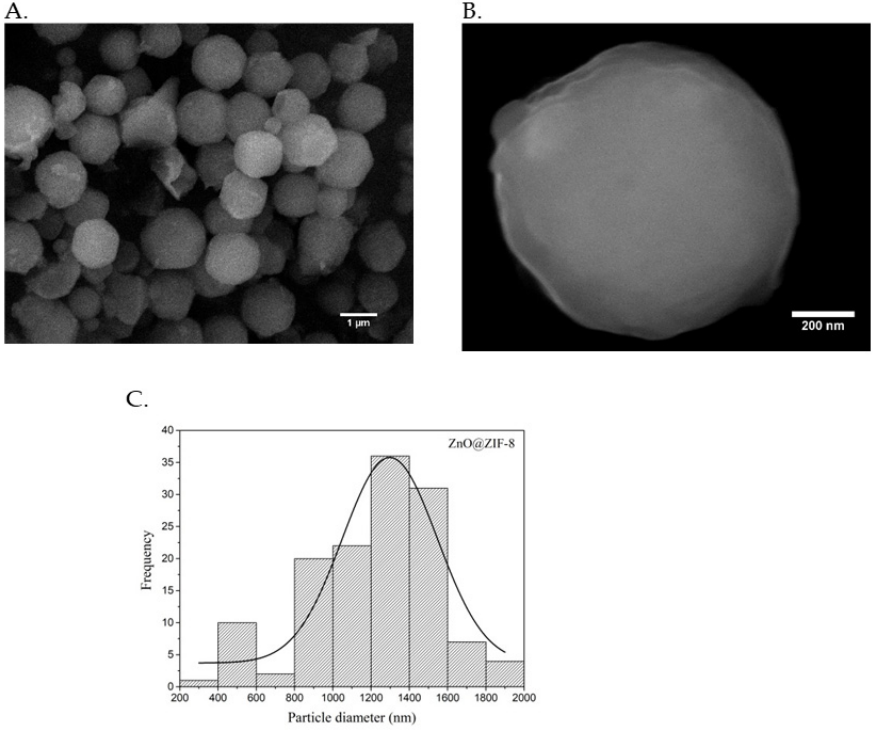
Figure 3. SEM images ( A , B ) and particle size distribution ( C ) of ZnO@ZIF-8 particles.